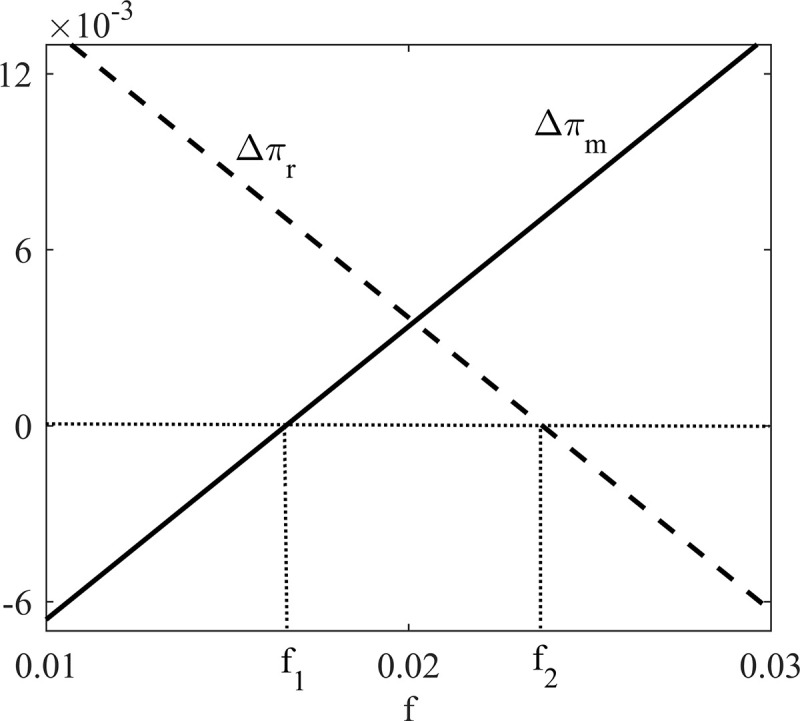
The optimal franchise fee FL*.